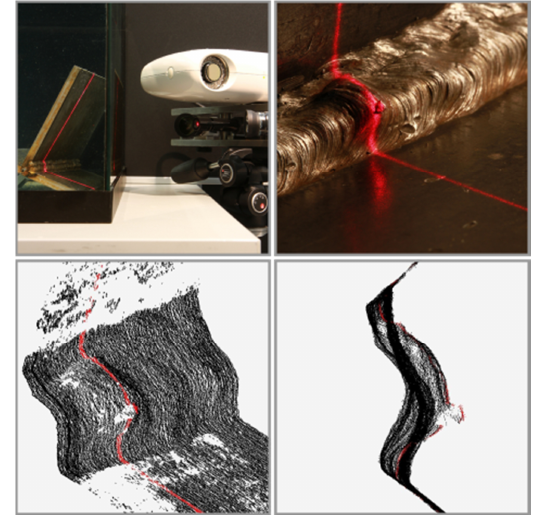
Figure 10. Laboratory setup of a welding seam measurement (top left), detailed image of a underwater welded seam with projected laser line (top right) and resulting point cloud of a welding seam measurement underwater; oblique view (bottom left) and side view (bottom